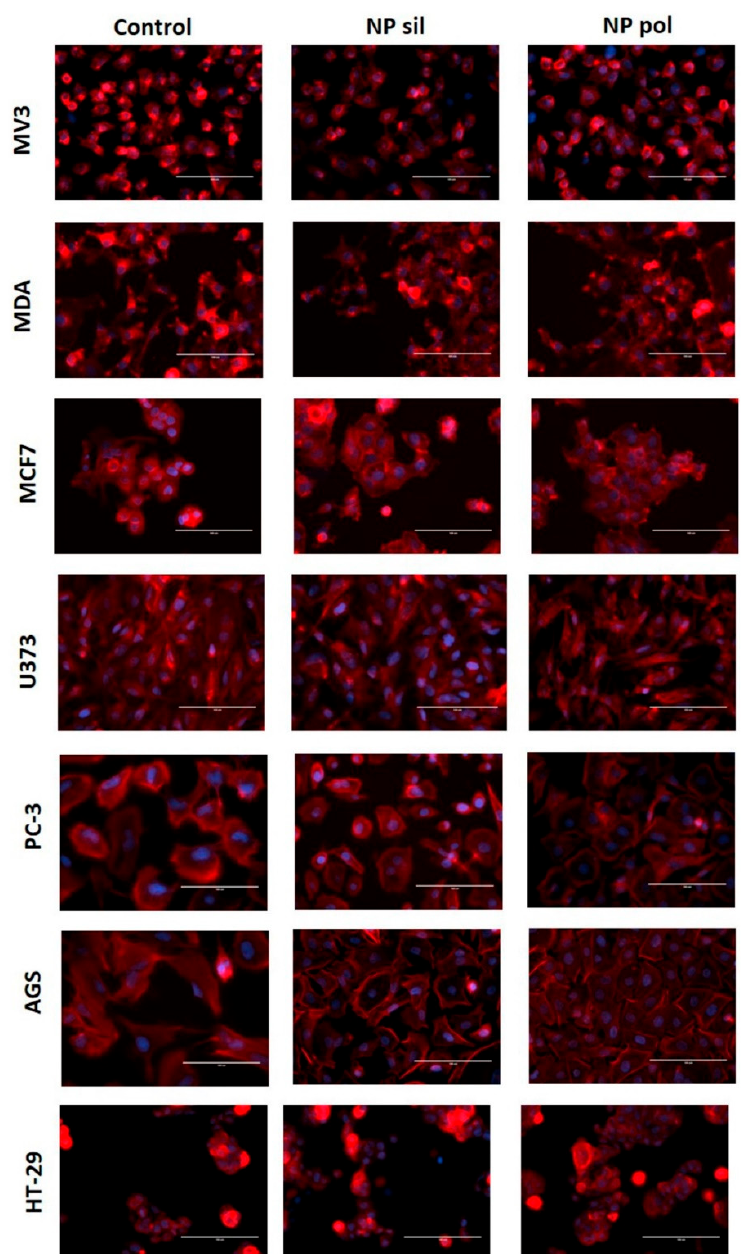
Figure 7. Effects of nanoparticles in tumor cells actin cytoskeleton. Tumor cells were incubated with polymeric (pol) and silica (sil) nanoparticles (20 µ g / mL) for 24 h. Filamentous actin was labeled with tetramethylrhodamine (TRITC)-phalloidin and nuclei were stained with 4,6-diamino-2-phenylindole (DAPI). Representative images from three individual experiments were captured at 400 × magnification.